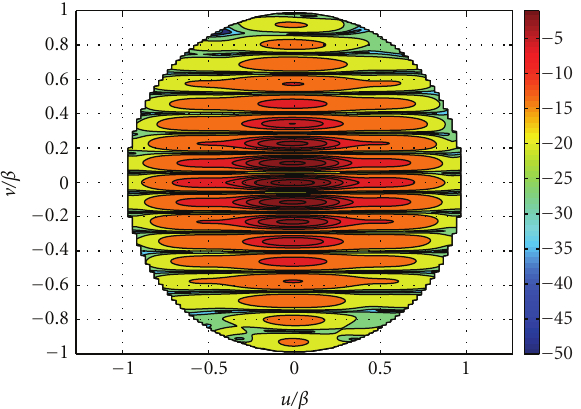
Figure 17: Dual horn, horizontal polarization, sum pattern. Amplitude of the ϕ component of the far field.